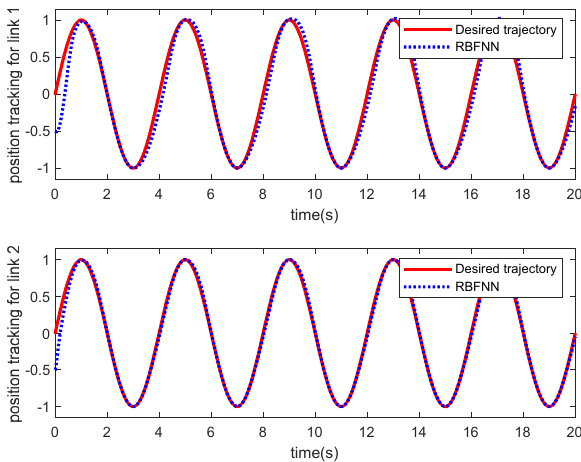
Figure 7. Trajectory tracking performance of the RBFNN.